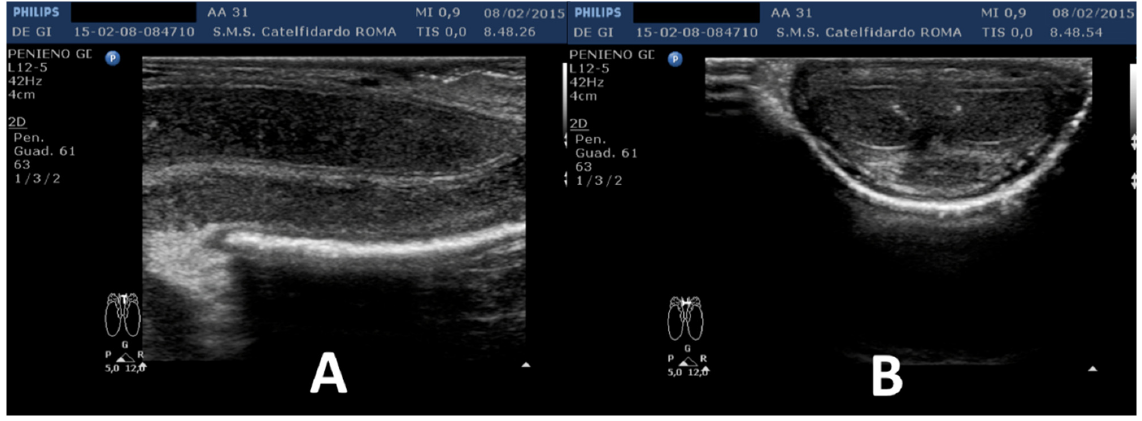
Figure 13. Ultrasonography of the penis after the first treatment cycle. ( A ) Longitudinal view, ( B ) transverse view.